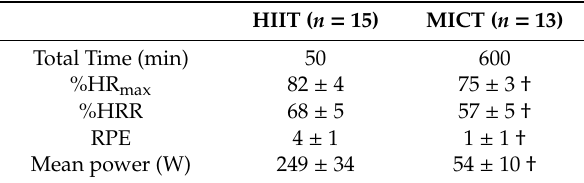
Table 3. Training data during 4-week intervention.